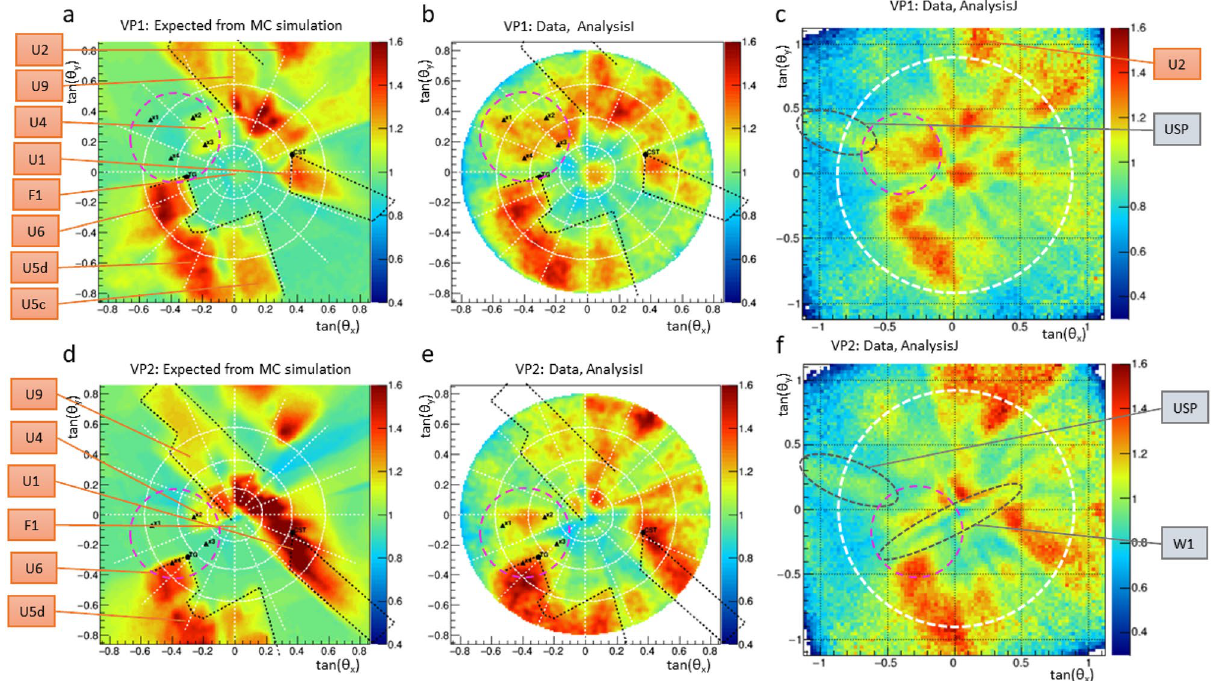
Figure 5. Muography images reporting the muon flux simulated using the 3D model ( a , d ) and measured ( b , c , e ), f ) all normalized to the one obtained by MC at the detector depth in the assumption of a bulk rock. Color scale represents the relative flux excess with respect to the one without cavities. ( a – c ) show the expected and measured AnalysisI and AnalysisJ , respectively, for the VP1 while ( d – f ) show the same quantities for the VP2. The white dashed circle in the ( c , f ) plots shows the angular acceptance of the AnalysisI